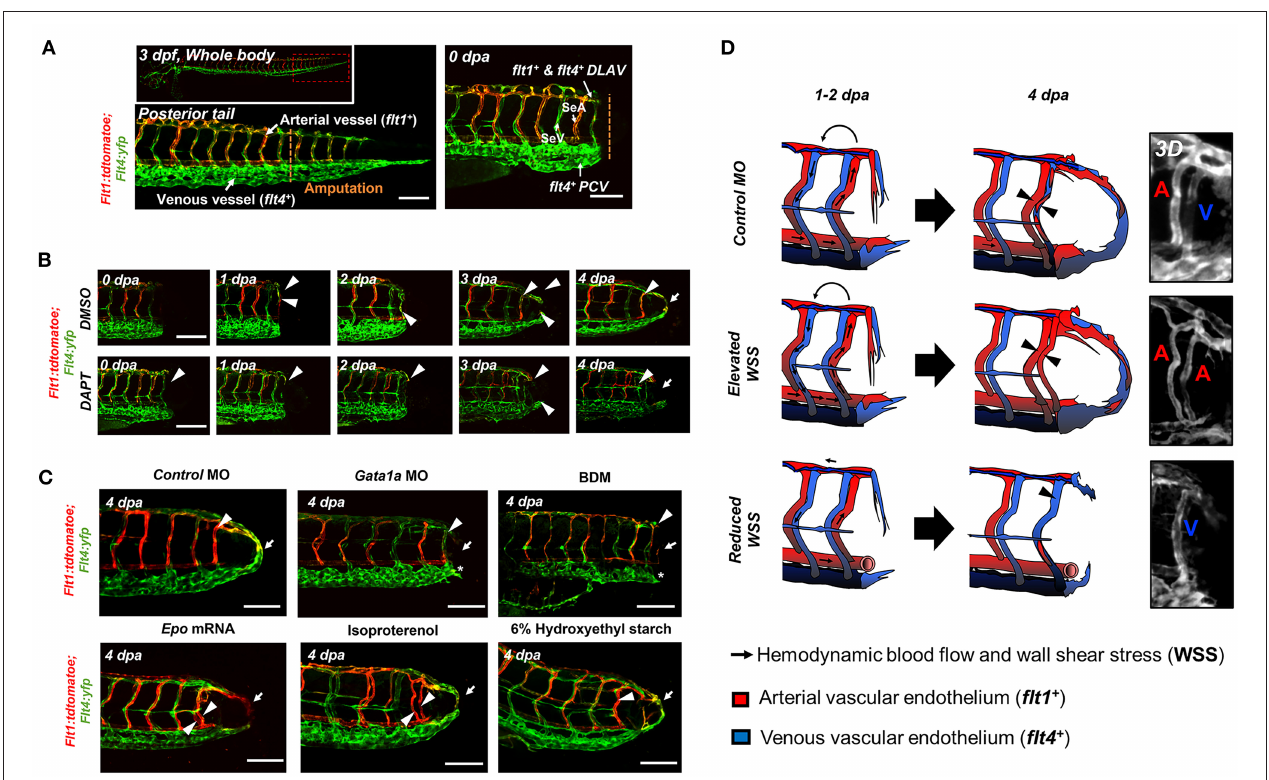
FIGURE 4 | WSS promotes Notch-mediated arterial network. (A) A representative image of tail vasculature in the transgenic Tg(flt1:tdtomatoe; flt4: yfp) zebrafish line at 3 dpf. flt1 + : arterial vascular endothelium, flt4 + : venous vascular endothelium. flt1 + & flt4 + DLAV: flt1 + or flt4 + regenerated from the DLAV. flt4 + PCV: flt4 + regenerated from the PCV. Scale bar: 100 µ m. (B) In response to DMSO treatment, flt1 + arteries preferentially formed an initial dorsal to ventral connection between the DLAV ( flt1 + DLAV) and the DA in the amputated site (white arrowhead). Between 1–2 dpa, flt4 + veins from the DLAV ( flt4 + DLAV) regenerated toward the DA exhibiting collateral arterial phenotype (overlapped yellow, white arrowheads). While regeneration of flt4 + veins occurred in the PCV ( flt4 + PCV) and DLAV ( flt4 + DLAV) for loop formation between 2–3 dpa, the distal segmental network exhibited enhanced flt1 expression at 3 dpa. flt1 + arteries extended dorsally from SeA at 4 dpa